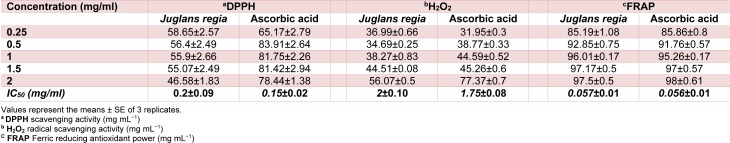
Antioxidant activities and phenolic contents in the ethanolic extract of Juglans regia